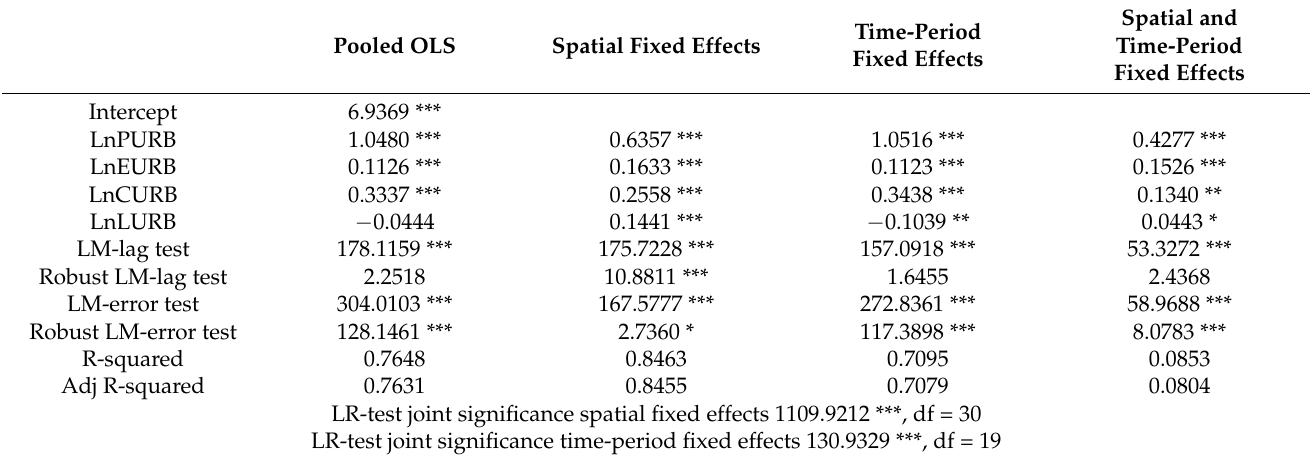
Table 16. LM test results and LR test results.